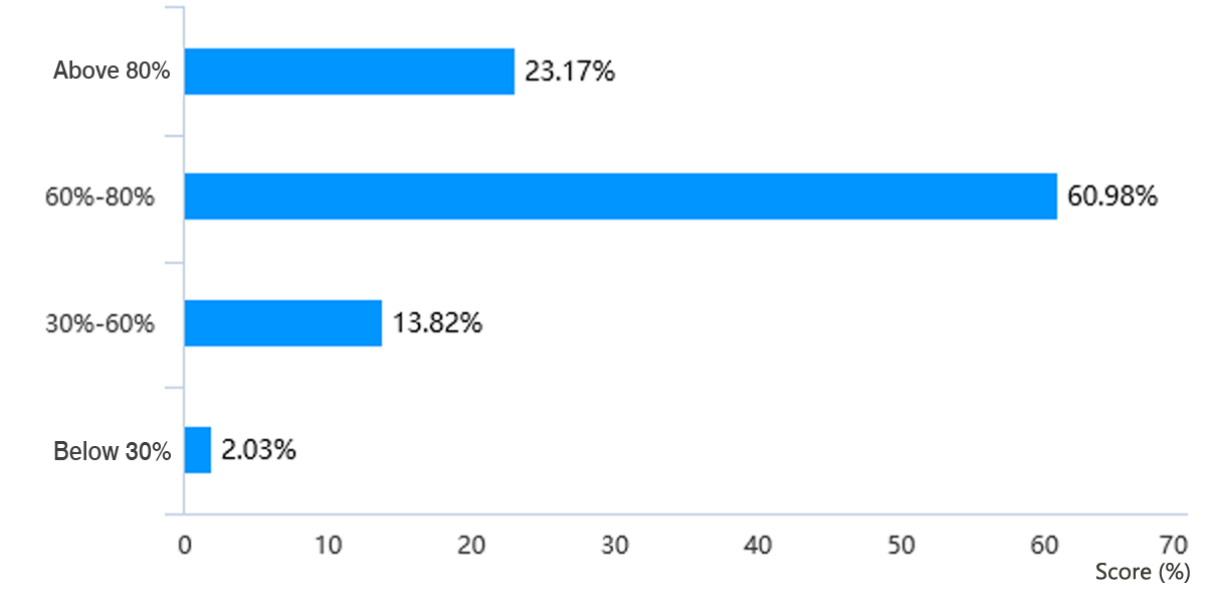
Figure 6. Scores showing the extent of students’understanding and mastery of the theoretical knowledge of pathology through web-based